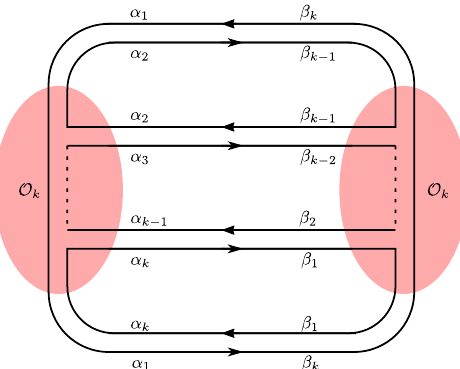
Figure 1. A planar diagram representing the B k two-point function with k contractions of double- lines. The shaded areas, from which the lines emanate, represent the single-trace operators O translate between the diagram and (7.31), we explicitly show the α to which they are being set